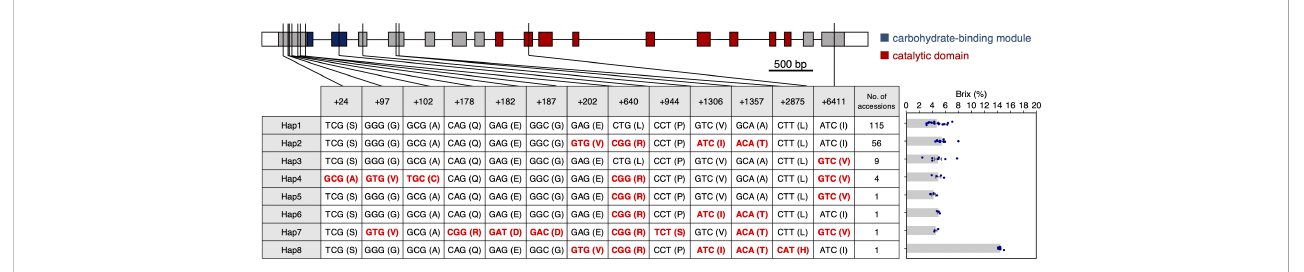
FIGURE 5 Haplotype analysis of SbSu . Eight haplotypes were observed in 187 accessions based on nonsynonymous SNPs in the coding region. Schematic diagram of SbSu is shown on the top (also, see Figure 2B). The number in the fi rst row of the table indicates the relative physical position from the transcription start site. Nonsynonymous mutations are indicated in red. For Hap5-7 (only one accession), data were obtained from more than three biological replicates.